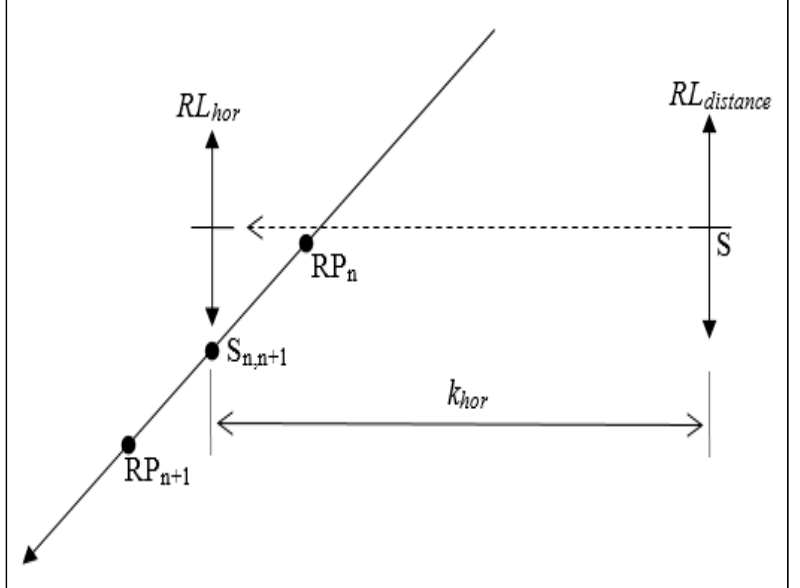
Figure 10. Correction of the reference length in the horizontal direction (source: The authors of this article). Table 1. Dependence of coefficient c hor on the interval of distance k hor.